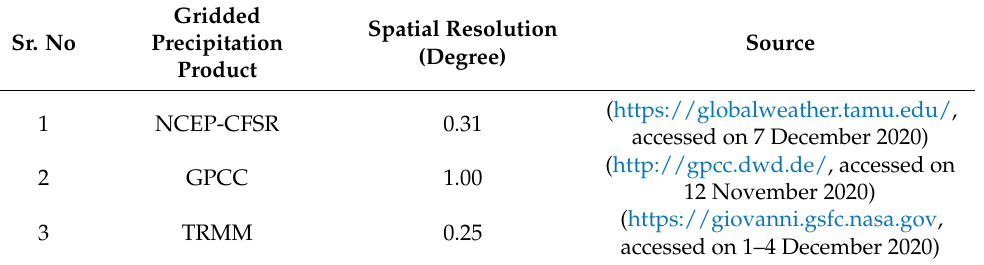
Table 1. Description of gridded precipitation datasets.